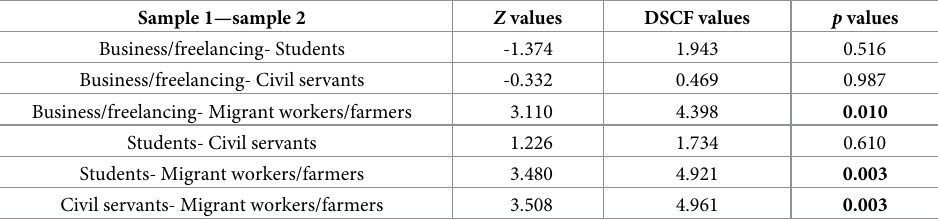
Table 2. Influence of different occupations on stigma of COVID-19 patients.